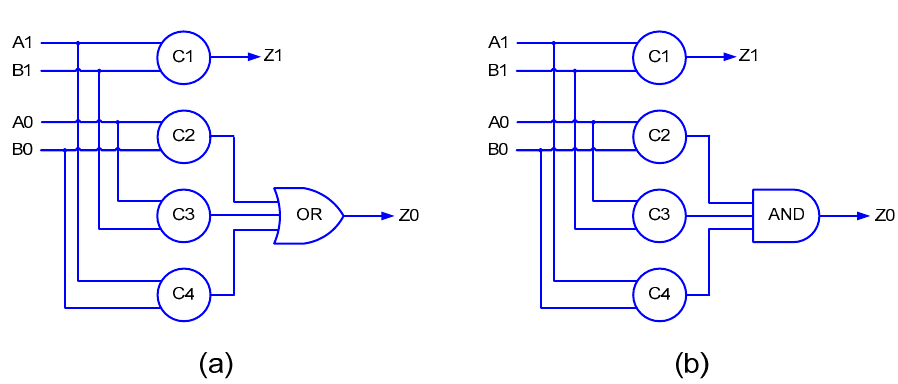
Figure 3. Schematic of the 4 × 4 array multiplier. The critical datapath encountered through the multiplier array for processing the data or the spacer is highlighted by the red dashed line. The notation ‘XjYk’ in Figure 3 represents a partial product.